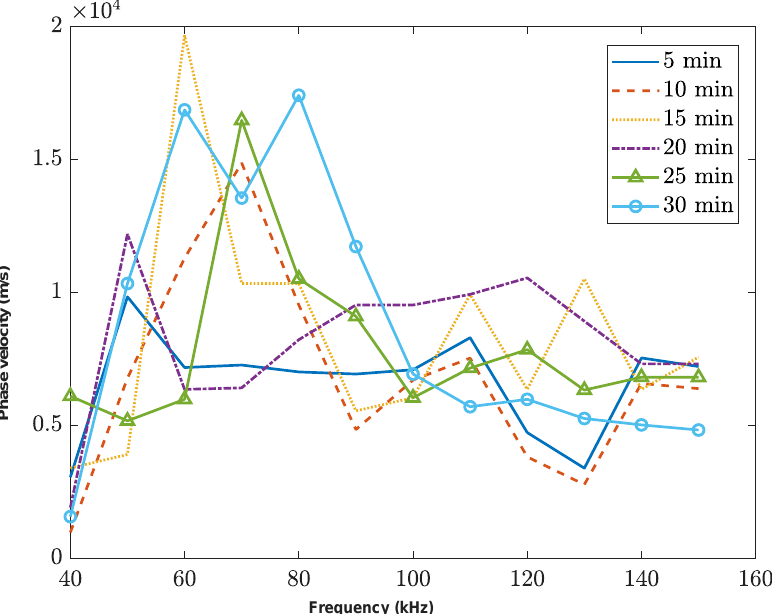
Figure 7. The phase velocity of surface wave experimental data analysis. The phase velocity with six different scanning times .